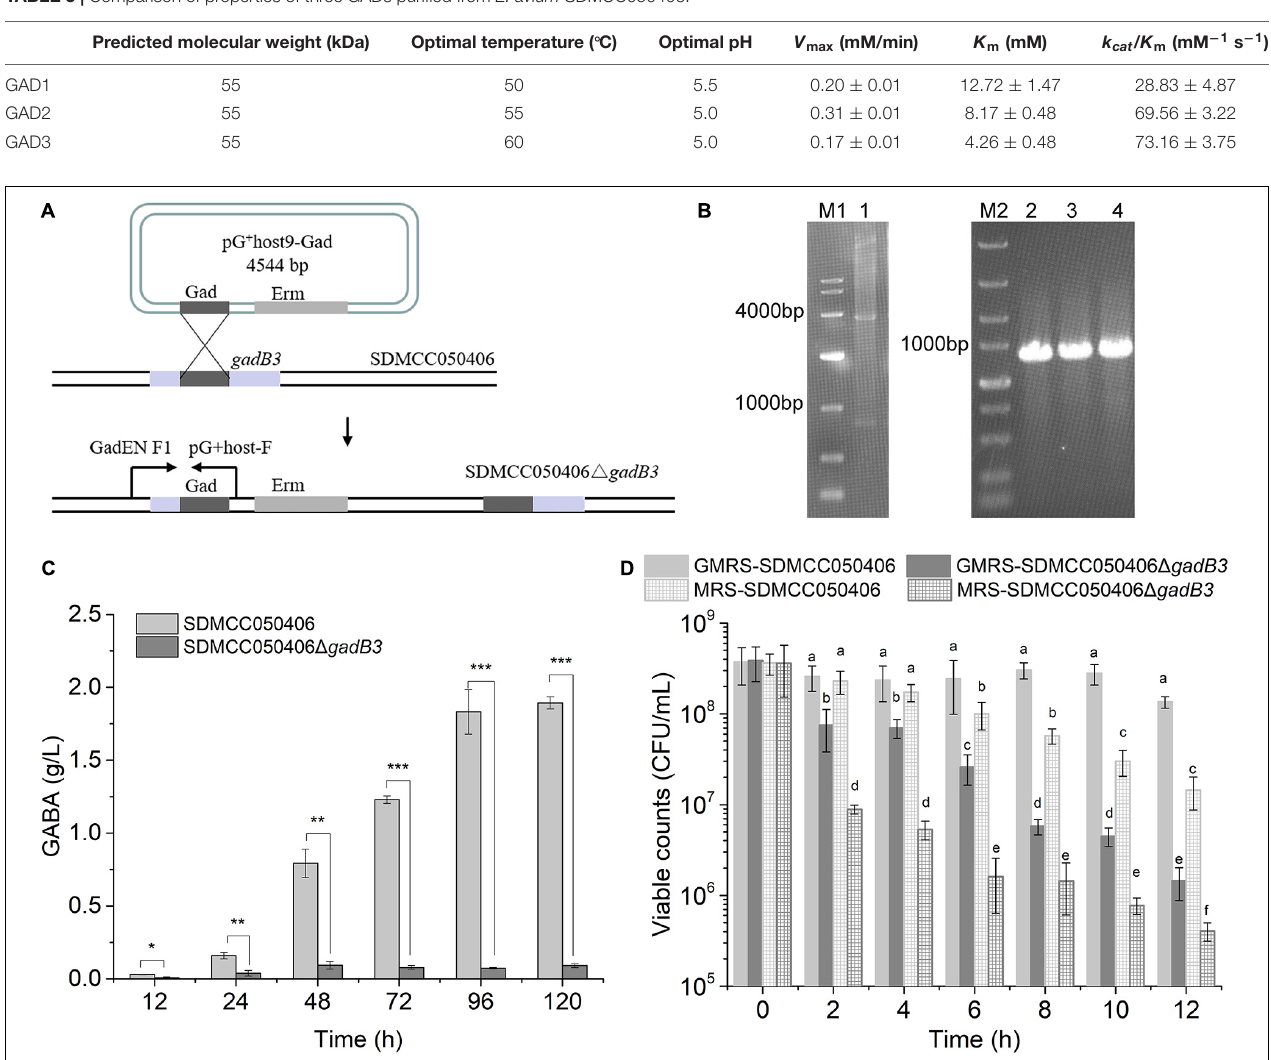
FIGURE 4 | Effect of gadB3 gene in GABA biosynthesis and acid tolerance. (A) Scheme for gadB3 gene inactivation in E. avium SDMCC050406. (B) Agarose gel electrophoresis of DNAs, lane M1, DL10,000 DNA Marker (TaKaRa, Japan), size range (10,000, 7,000, 4,000, 2,000, 1,000, 500, and 250 bp); lane 1, the product of pG + host9-Gad digested by EcoR I and Hind III (TaKaRa, Japan); lane M2, DL5,000 DNA Marker (TaKaRa, Japan), size range (5,000, 3,000, 2,000, 1,500, 1,000, 750, 500, 250, and 100 bp); lane 2 to lane 4, PCR products with the primer pair GadEN F1 and pG + host-F using the template DNA extracted from three E. avium SDMCC050406 (cid:49) gadB3 clones. (C) GABA production of E. avium SDMCC050406 (black column) and E. avium SDMCC050406 (cid:49) gadB3 (gray column) cultured in GMRS. Asterisk represented the statistical significance of GABA. (D) Viable cell counts of E. avium SDMCC050406 (black line) and E. avium SDMCC050406 (cid:49) gadB3 (gray line) under acidic condition of pH 3.5. The cells were harvested at 2-h intervals over 12 h. Error bars represented standard errors from three replicate experiments. The lowercase represented the statistical significance of viable counts. * p -value < 0.05, ** p -value < 0.01, and *** p -value <